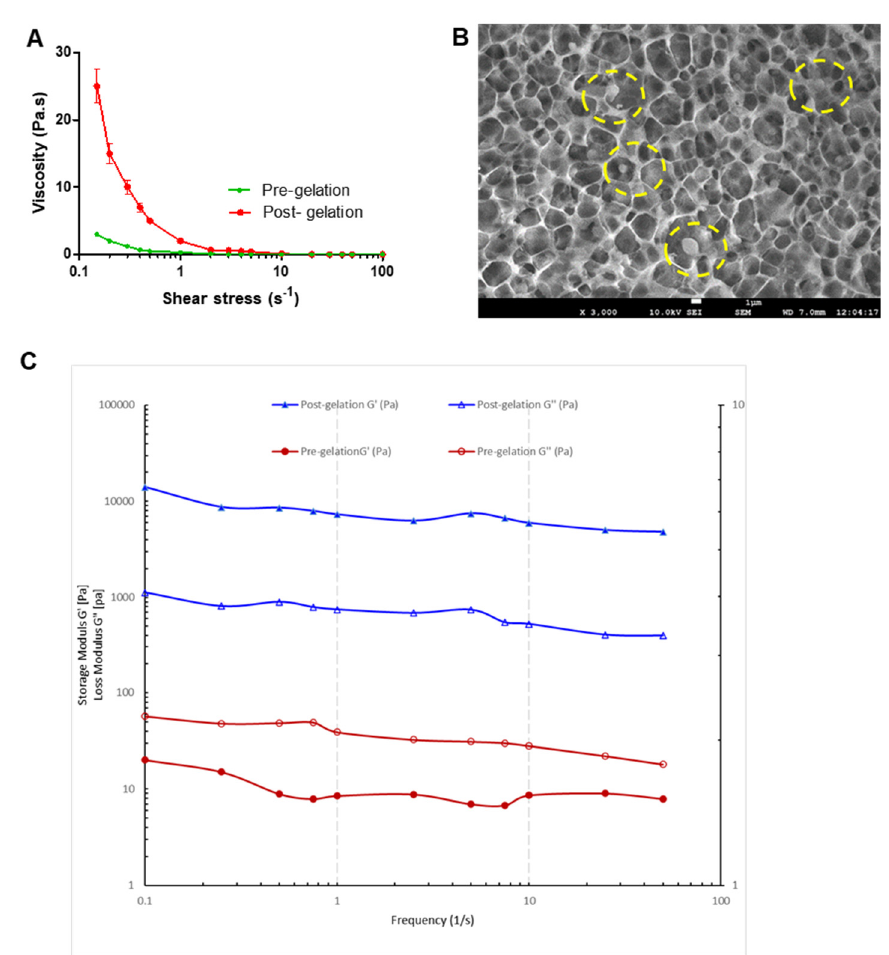
Figure 4. ( A ) Rheological profiling of naringin loaded in situ gelling nanoemulgel depicting change in viscosity with increase in rate of shear before mixing with SNF (Pre-gelation) and after mixing with SNF (Post-gelation). ( B ) SEM image of naringin loaded in situ gelling nanoemulgel after mixing with SNF showing three-dimensional network entrapping nanoemulsion droplets (5 mm = 100 nm). ( C ) Frequency sweep evaluation showing comparative G ′ (storage modulus, solid markers) and G ″ (loss modulus, hollow markers) of the naringin loaded in situ gelling nanoemulgel pre- and post- gelation.